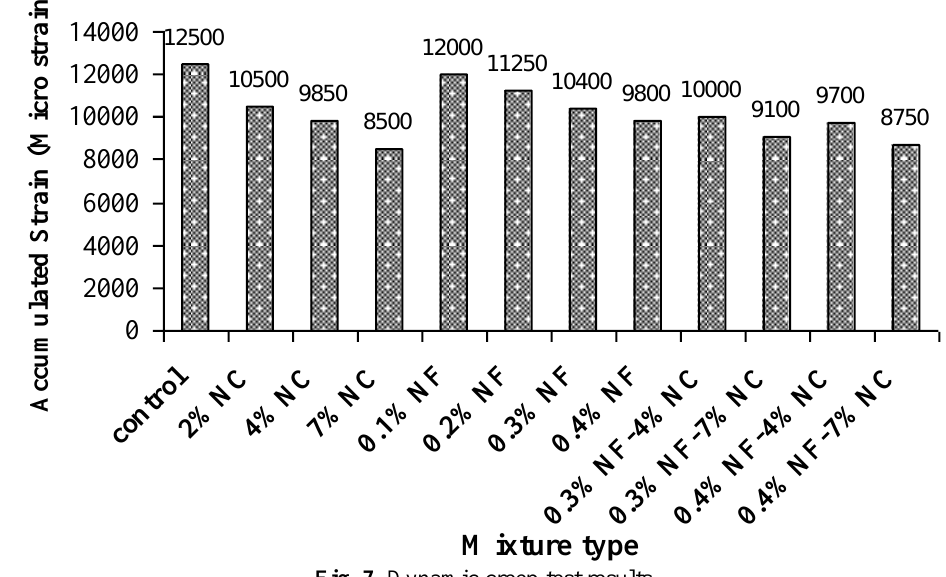
Fig. 7. Dynamic creep test results